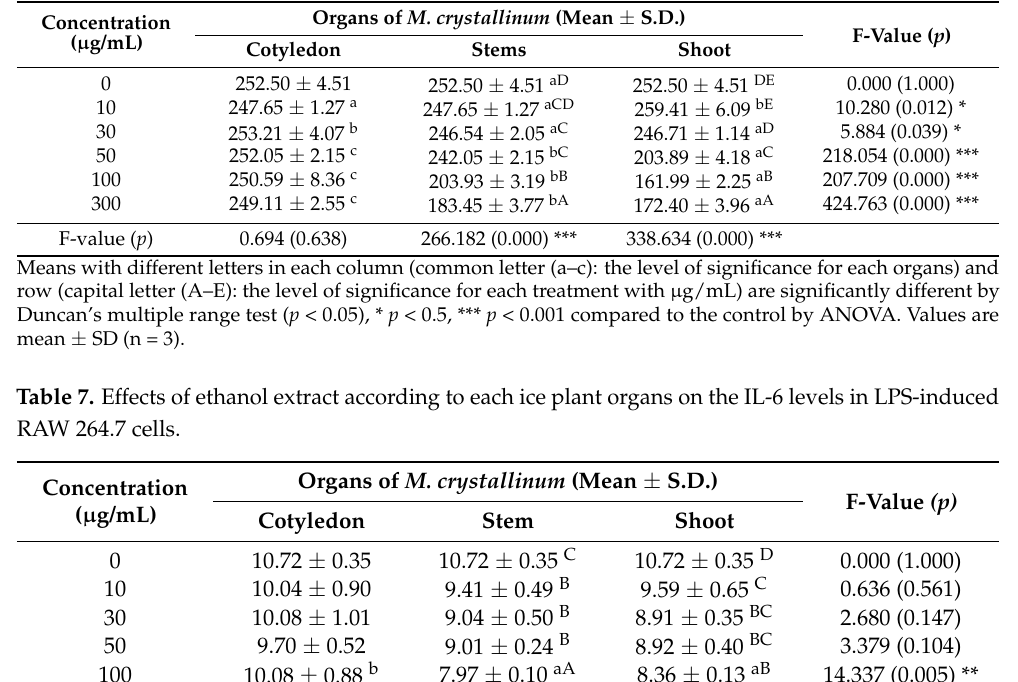
Table 6. Effects of ethanol extract according to each organ of the ice plant on TNF-a levels in LPS-induced RAW 264.7 cells.